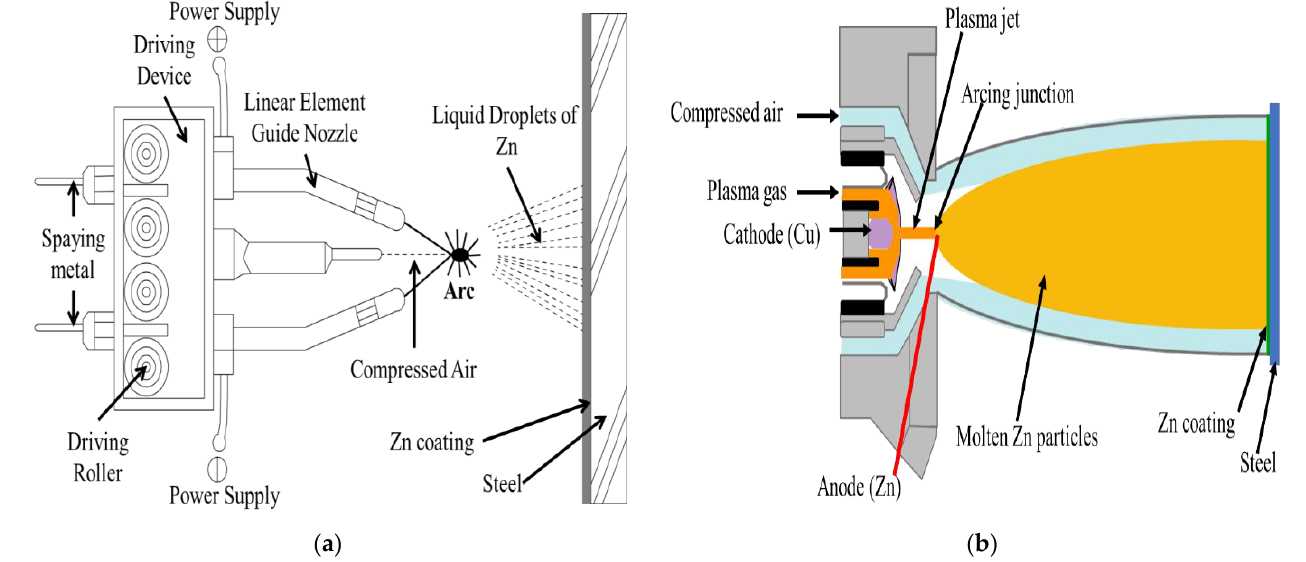
Figure 1. Schematic of ( a ) arc and ( b ) plasma arc thermal spray coating processes.